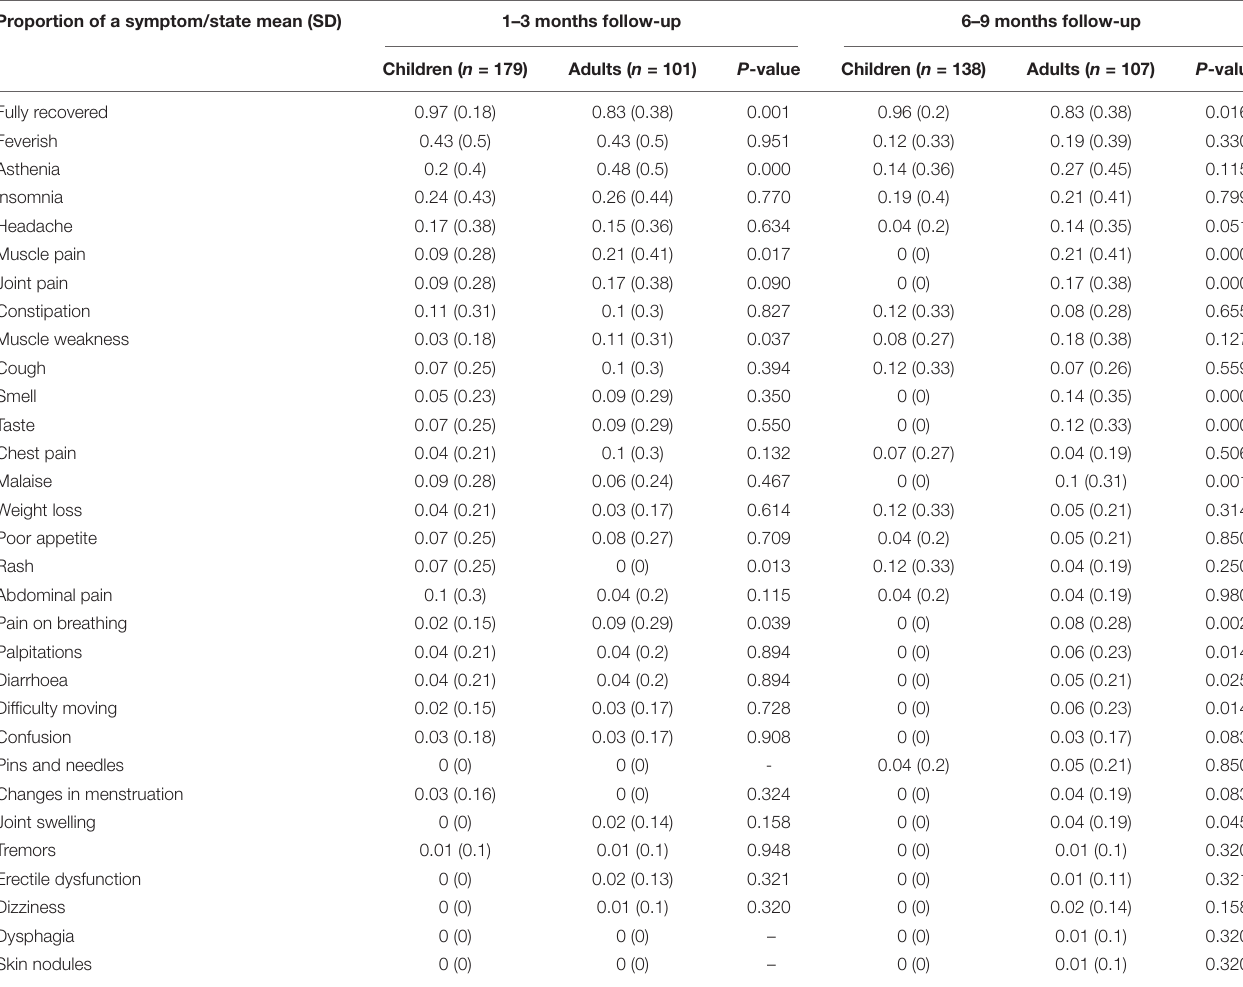
TABLE 2 | Comparison of proportion of symptoms between adults and children with PCR – confirmed SARS-CoV-2